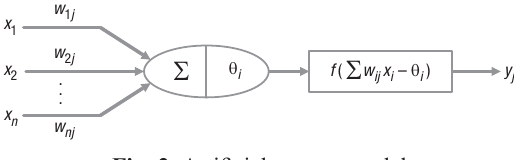
Fig. 2. Arti fi cial neuron